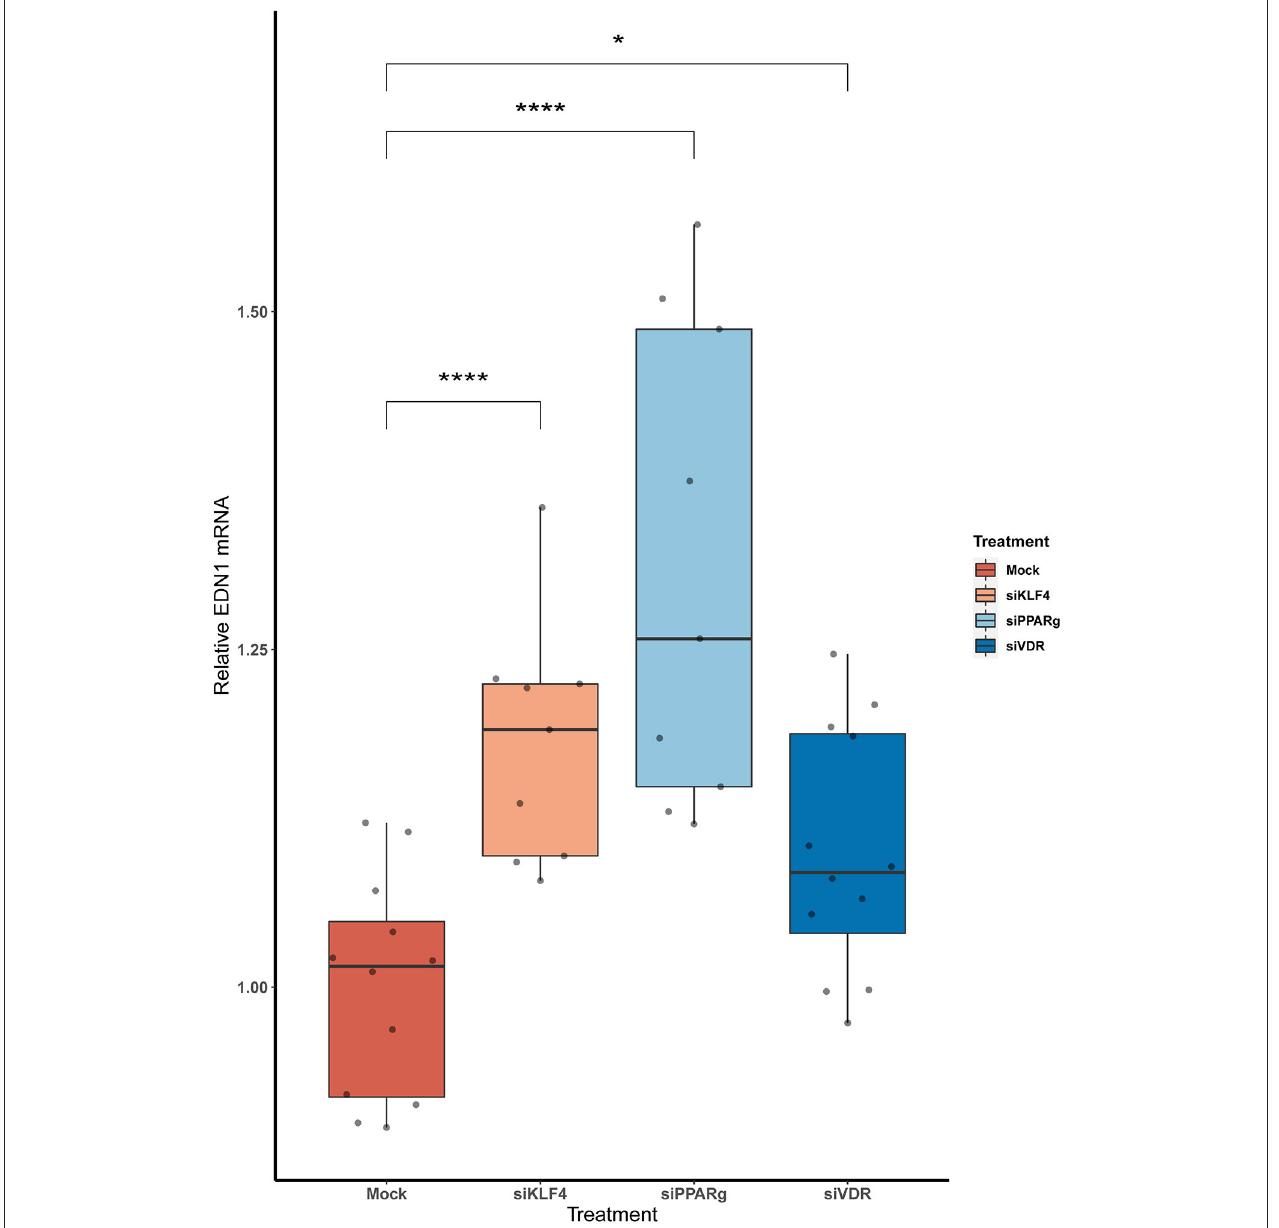
FIGURE 2 | The KD of PPAR γ , KLF4, and VDR increase the mRNA levels of EDN1. Data are shown as box plots depicting the quartiles ( n = 3). Dots represent technical replicates. A Kruskal-Wallis test with a Dunn’s correction was used for statistical analysis (* p > 0.05, **** p > 0.0001). EDN1, Endothelin-1; PPAR γ , peroxisome proliferator-activated receptor γ ; KLF4, Krüppel-Like Factor 4; VDR, vitamin D receptor. input % (2.17 ± 0.45) than the negative control IgG (0.71 ± 0.26; Figure 5B